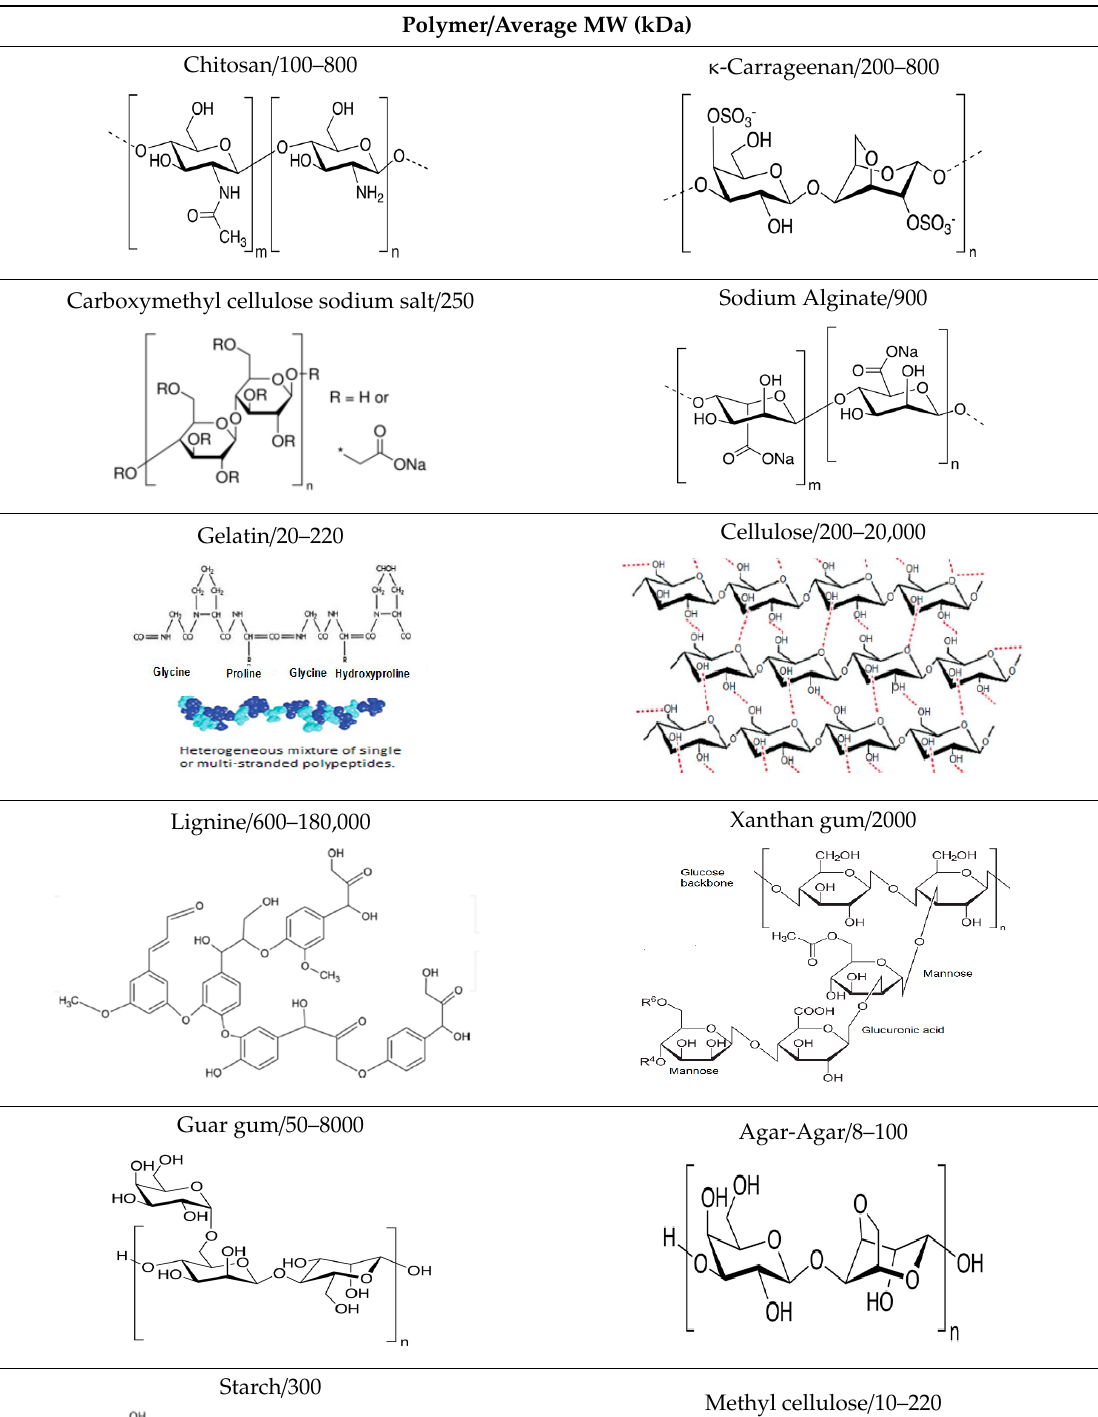
Table 4. Common popular biobased polymers used for making Zinc batteries GPEs-based.